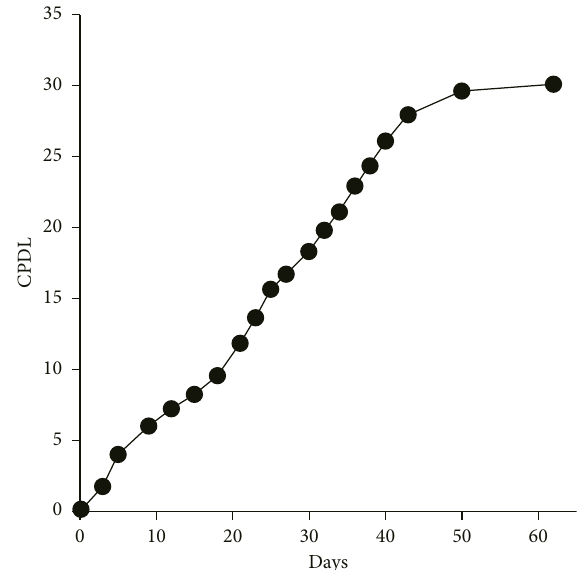
Figure 3: Proliferation curve of HUVECs at diferent